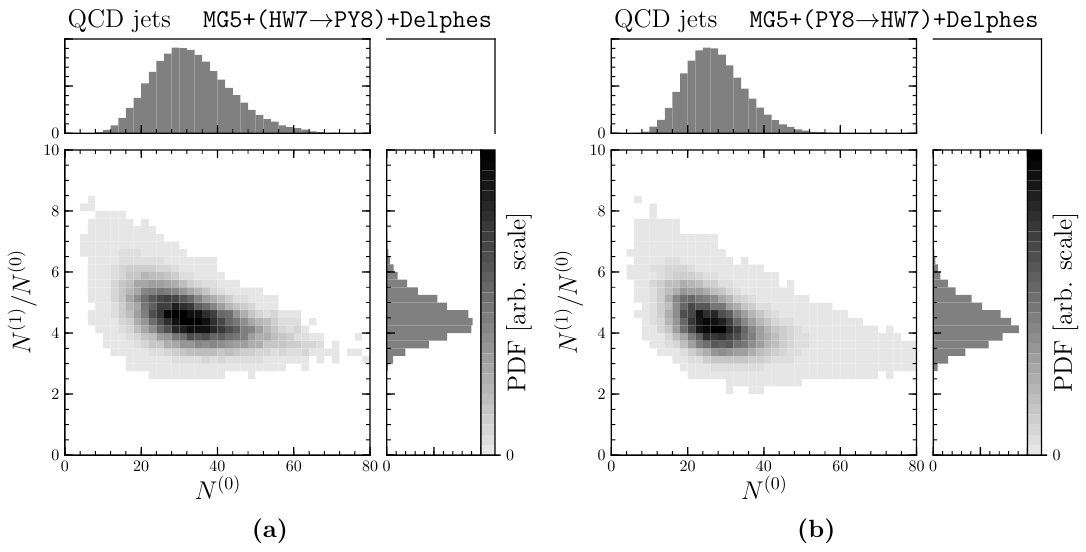
Figure 25. N pixel vs N 1 =N pixel for (a) the weigthed HW7 sample to reproduce PY8 distribution and (b) the weighted PY8 sample. to reproduce HW7